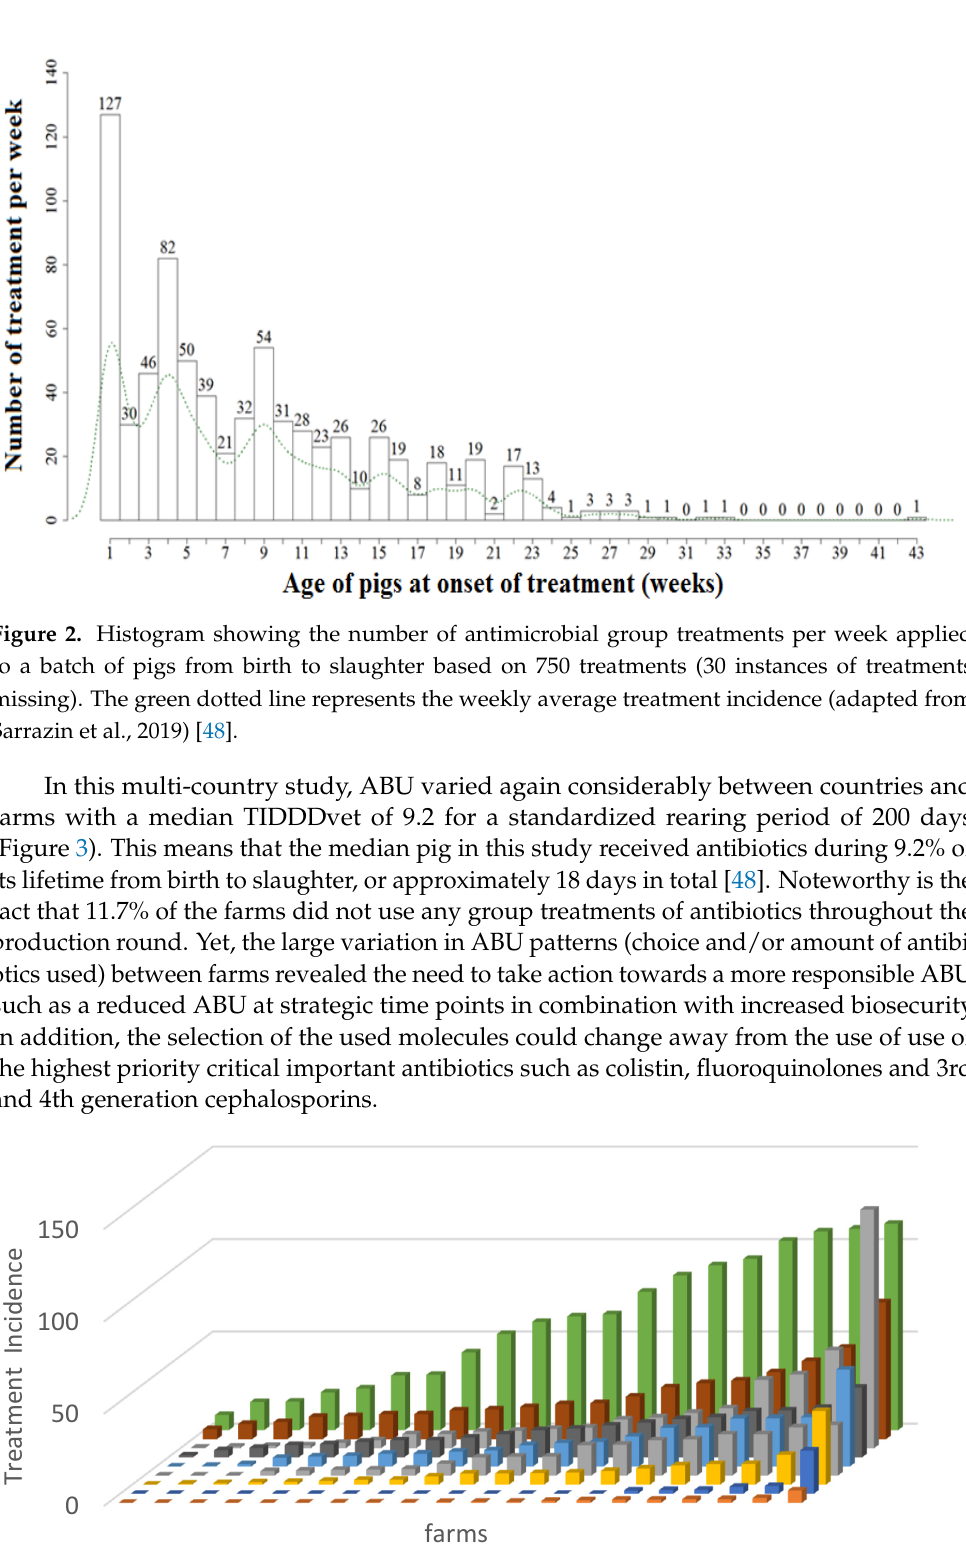
Figure 3. Country-level comparison of TI per 100 pig-days at risk, based upon group treatment data for a standardized lifespan of 200 days based on defined daily doses for animals (TI200 DDDvet ). Every color represents a different European country included in the study (9 countries). Every beam represents a farm (20 farms per country) (adapted from Sarrazin et al., 2019) [49]. Extended spectrum penicillins (31.2%) and polymyxins (24.7%) were the active